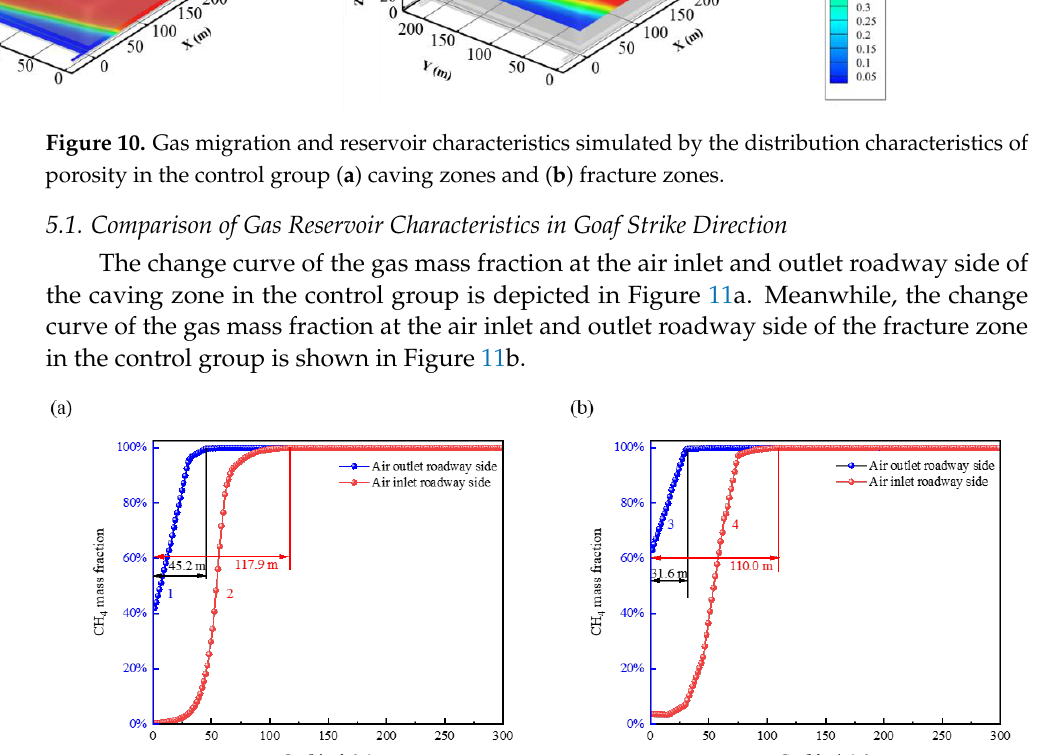
Figure 12. Comparison of the influence depth of gas mass fraction in the strike direction between the experimental and the control groups. It can be seen from Figure 12 that the influence depth of the gas mass fraction in the experimental group was greater than that in the control group, but the porosity of the fracture zone in the experimental group was less than that in the control group. This was due to the fact that although the porosity around the fracture zone was small, when it retracted to the middle of the goaf, the porosity rose promptly, resulting in the influence depth of the gas mass fraction in the experimental group being greater than that in the control group, indicating that the gas was easy to migrate in the area with large porosity.